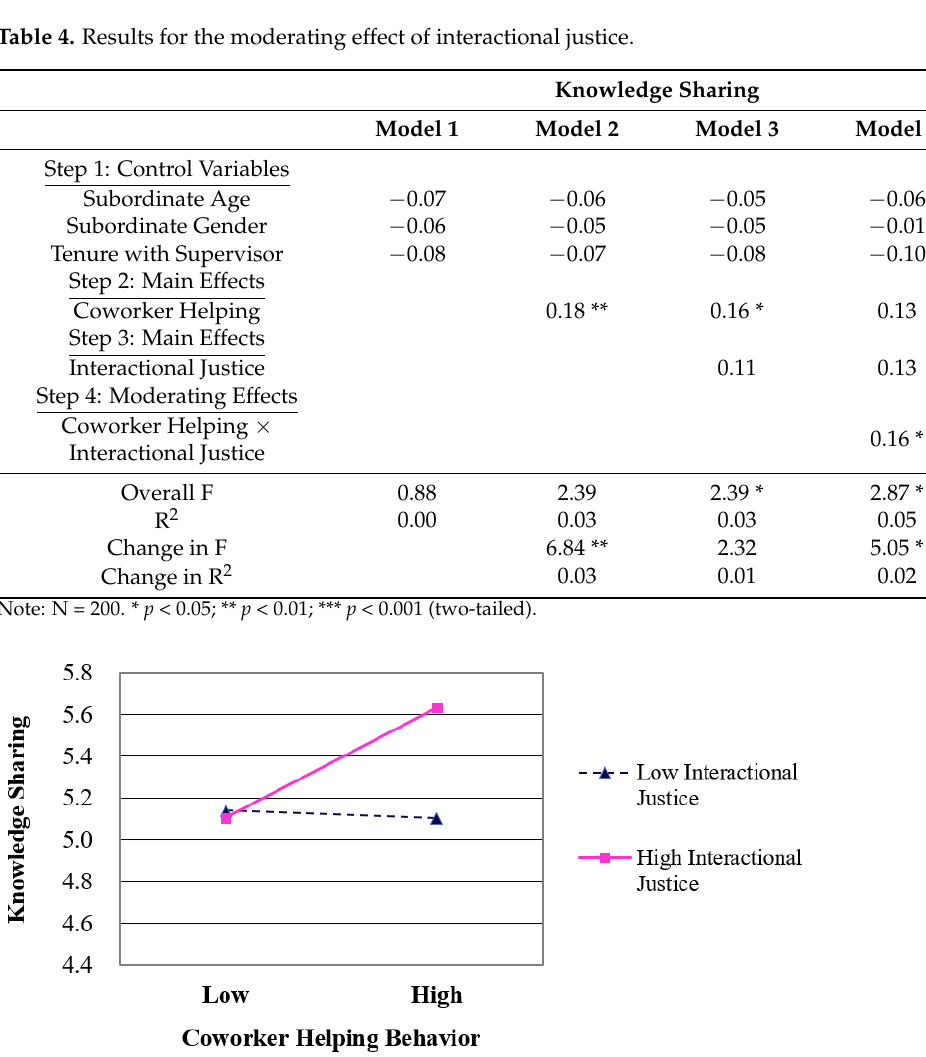
Figure 2. Moderating effect of interactional justice on the relationship between coworkers’ helping behavior and knowledge sharing.